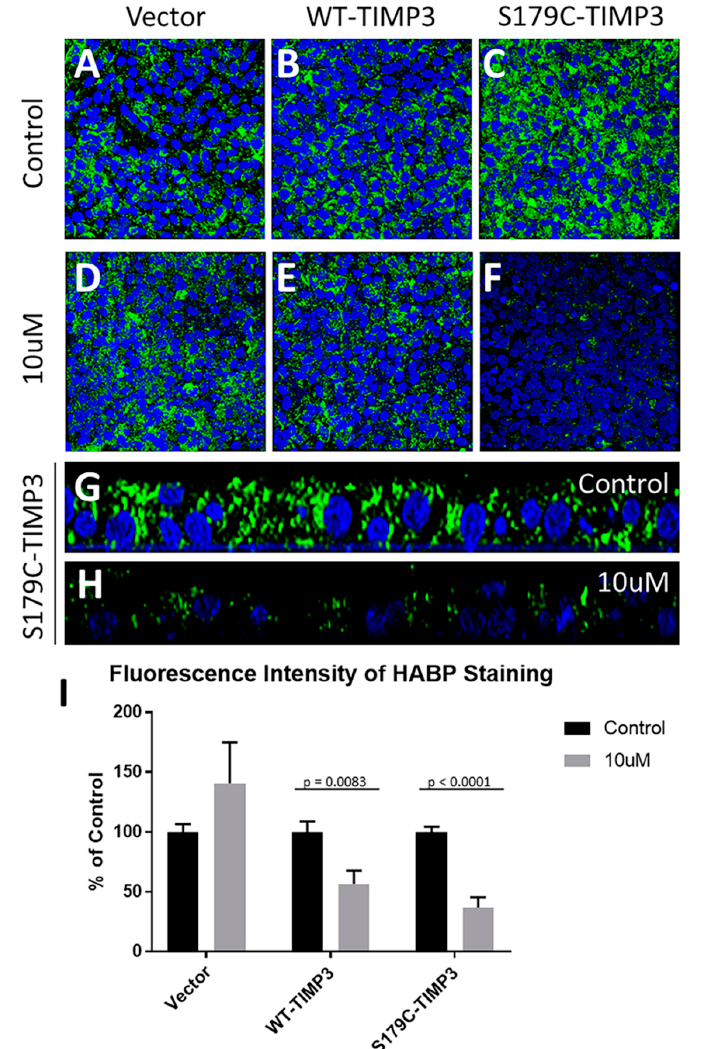
Figure 5. Inhibition of FGF signaling decreases HA accumulation in S179C-TIMP3 RPE cells. Vector only ( A ), WT-TIMP3 ( B ), and S179C-TIMP3 ( C ) expressing ARPE-19 cells were grown on trans-well inserts for 4 weeks before treatment with FGF receptor inhibitor BGJ-398. Treatment with BGJ-398 decreased HA accumulation in S179C-TIMP3 expressing RPE cells ( F , H , I ) and to a lesser extent in WT-TIMP3 expressing cells ( E , I ) but has no effect on control vector RPE cells ( A , D , I ). ( I ) Control (Black Bar) indicates respective untreated cells compared with BGJ-398 treated cells (Grey bar). ( G , H ) Z-plane images of S179C-TIMP3 cells in the absence ( G ) and presence ( H ) of 10 µ M BGJ-398 S179C-TIMP3 cells show an overall reduction in HA accumulation, including intracellular HA, after treatment with BGJ-398. Green: HA; blue: DAPI. ( I ) data are presented as mean ± SEM (n ≥